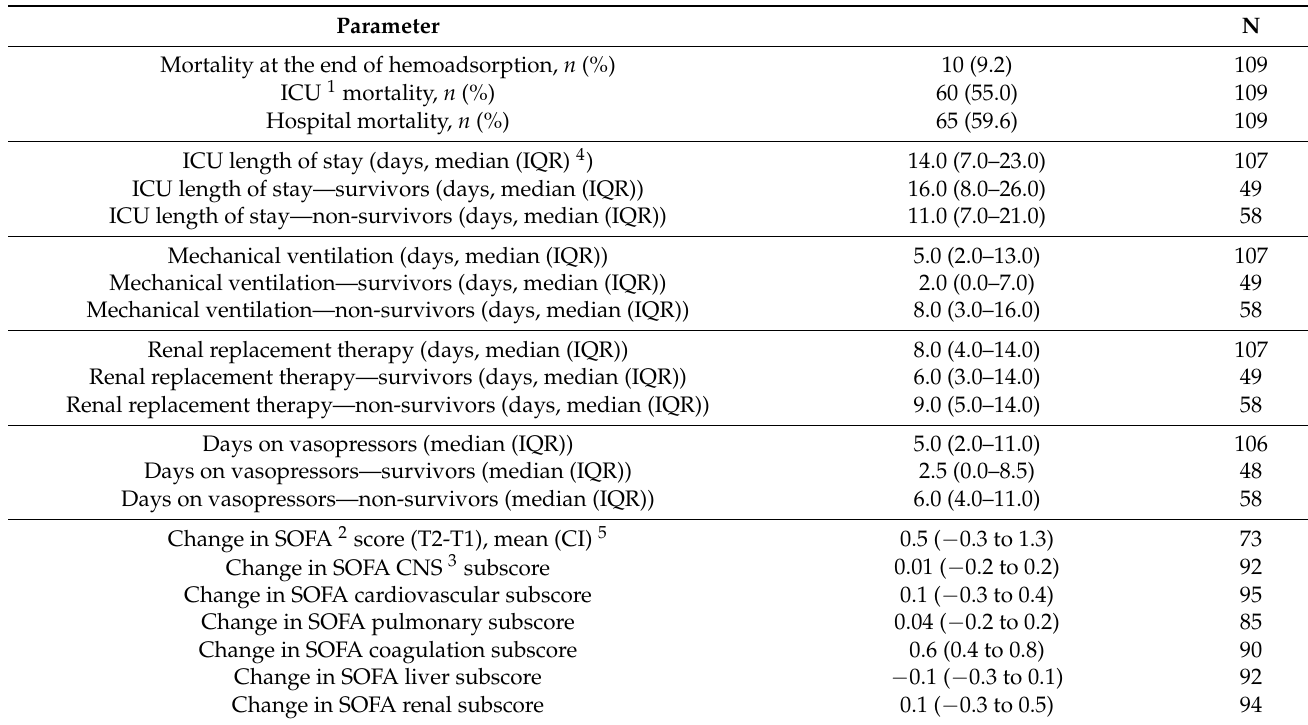
Table 3. Outcome